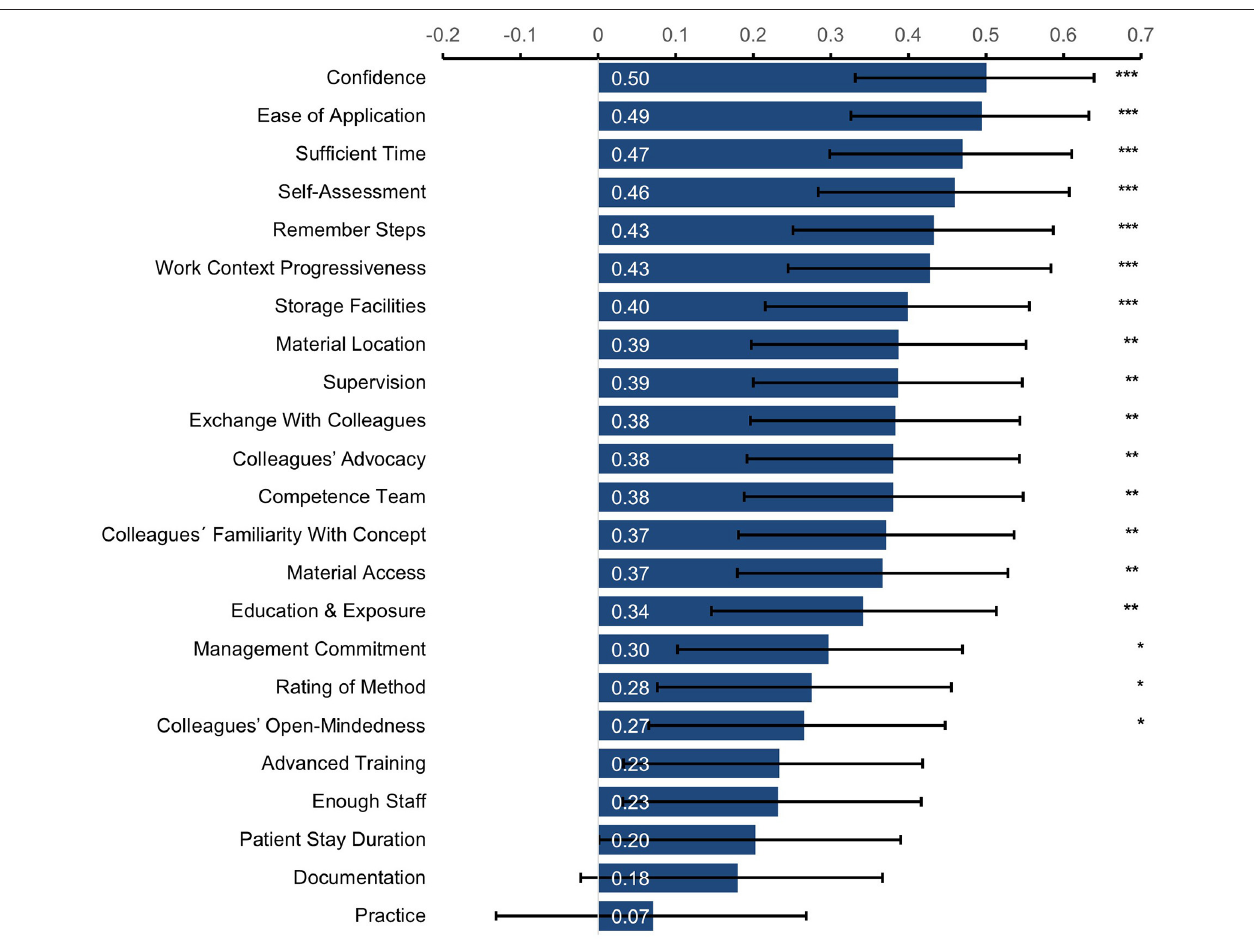
FIGURE 1 | Spearman’s rank correlation coefficients between self-reported LiN-use and the individual questionnaire items. Items are ordered by the size of the correlation coefficient. *** p < 0.001, ** p < 0.01, * p < 0.05 (adjusted for multiple comparisons using Holm-Bonferroni correction). Error bars show 95% confidence